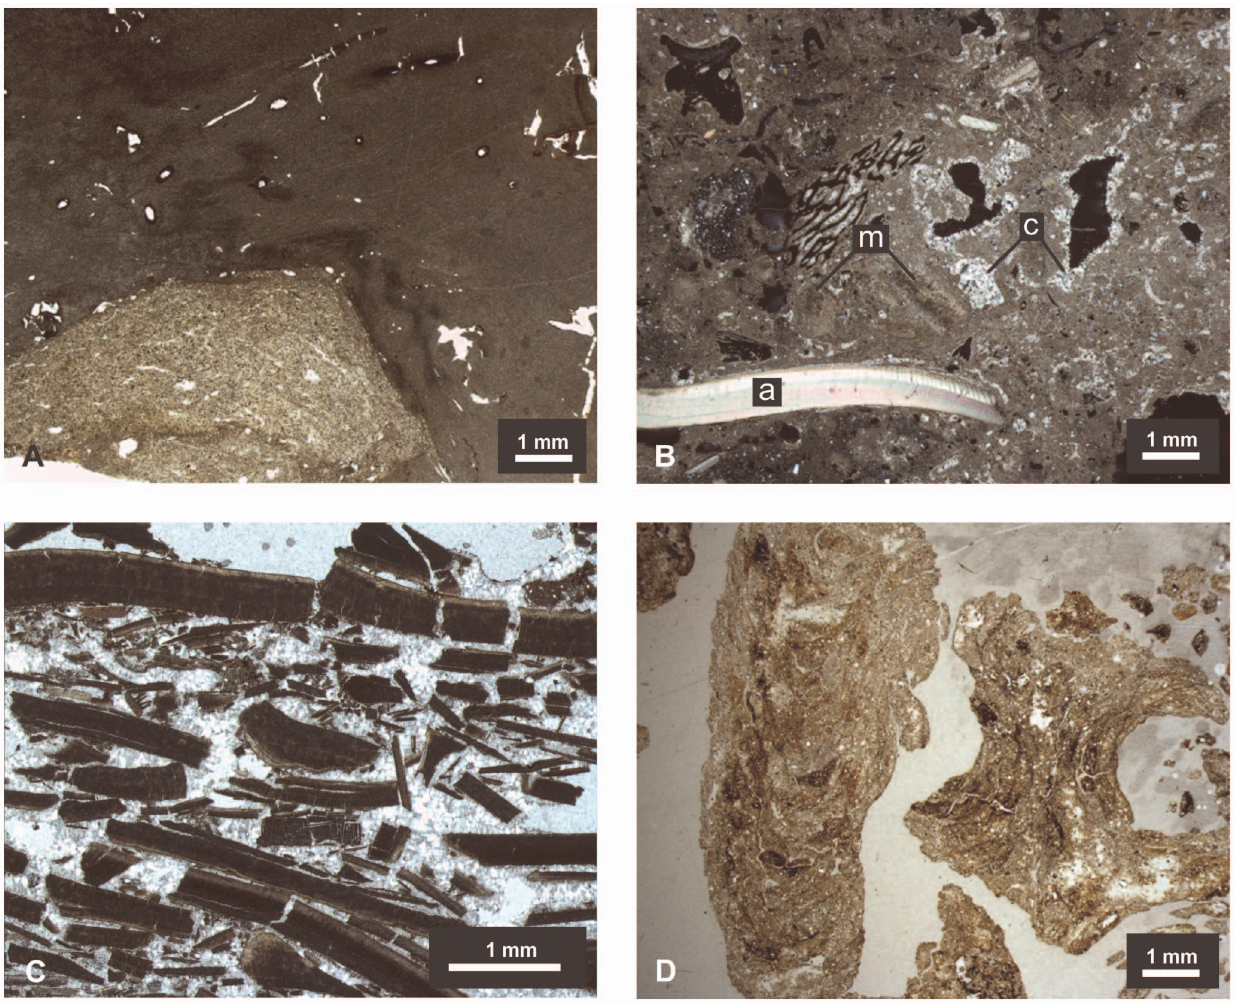
Figure 6. Micromorphology of SM1’s key features and units. A) Fragment of burnt earth from Unit II showing a relatively undisturbed mass of clay with a cluster of coarser material; the association of two different materials suggests reworking, but the presence of root channels indicates it was limited (PPL); b) Unit IIIa at depth 45 cm; ‘‘a’’ indicates an aragonitic shell fragment, ‘‘m’’ indicates recrystallized shell fragments and ‘‘c’’ indicates precipitated calcite crystals (XPL); c) Unit V at depth 130 cm entirely constituted by burnt shell fragments and precipitated calcite (plane polarized light, PPL); d) Biogenic burnt earth fragments at depth of 75 cm; on the left a longitudinal cut of the chamber; on the right a transversal cut of the chamber